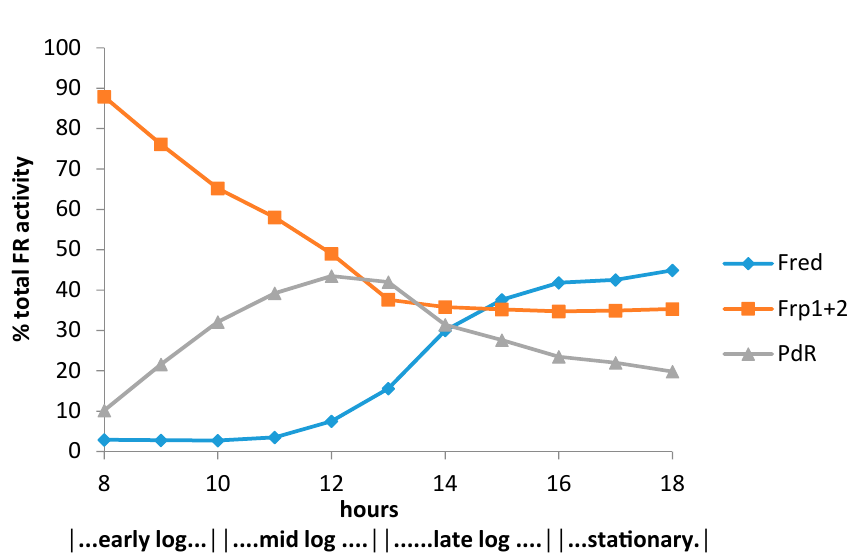
Figure 5. Relative contribution of the different assayed FNR-generating enzymes to the total flavin reductase activity titre throughout the various phases of camphor-dependent growth of P. putida NCIMB 10007.